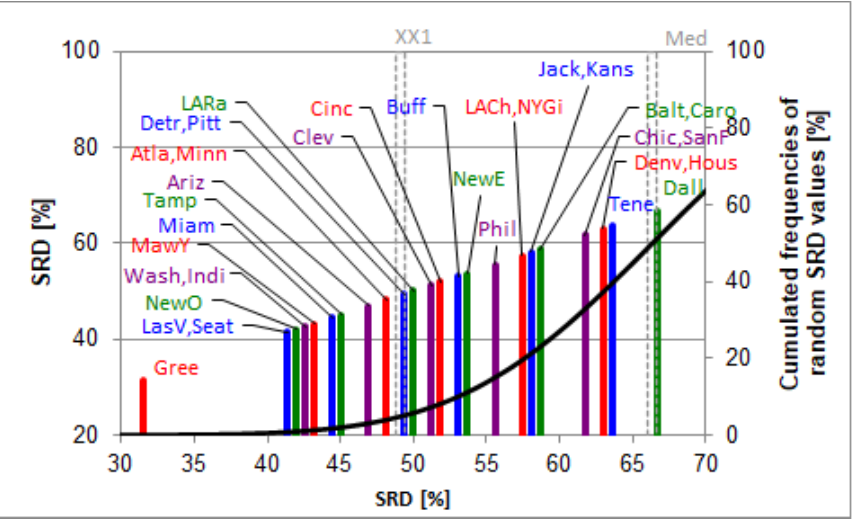
Figure 7. The SRD values (scaled between 0 and 100, blown up part) of the teams based on experts’ ratings determined by sum of ranking differences. Row-average values were used as the reference (benchmark) column. Scaled SRD values are plotted on the x axis and left y axis, right y axis shows the relative frequencies of random ranking distribution function: black curve. The probability ranges are also given as 5% (XX1), Median (Med), and 95% (XX19). Codes of the teams are listed in the data set section.